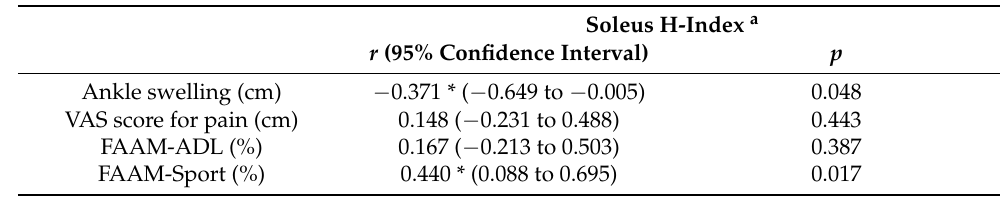
Table 2. Pearson correlation coefficients between the conduction velocity of the soleus spinal reflex and acute symptoms in ALAS